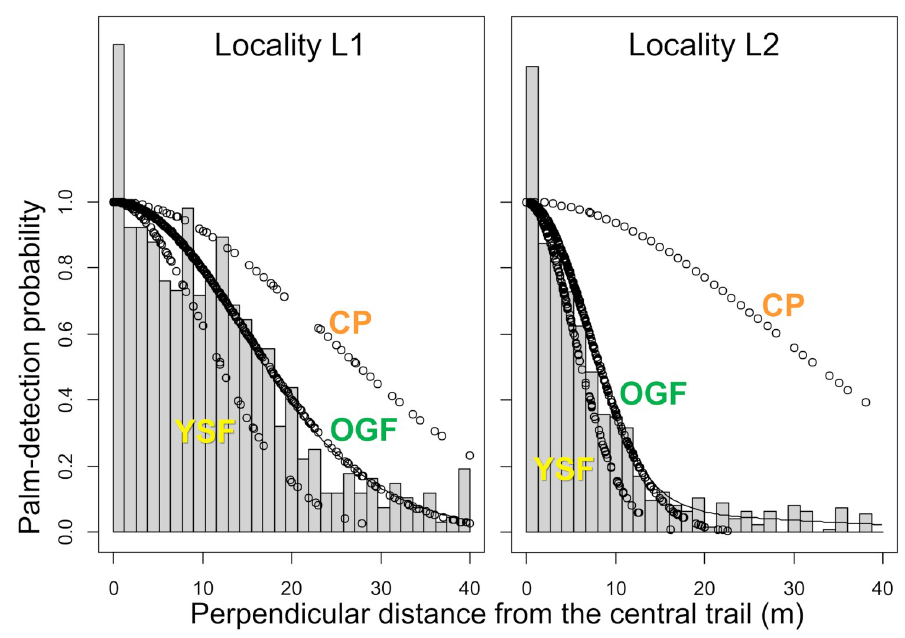
Fig 3. Estimated decline of Attalea palm detection probabilities as a function of distance. Results are shown by locality (“L1” and “L2”) and by landscape class (“OGF”, old growth forest; “CP”, cattle pasture; “YSF”, young secondary forest) within localities. Gray bars are overall palm-detection frequencies.